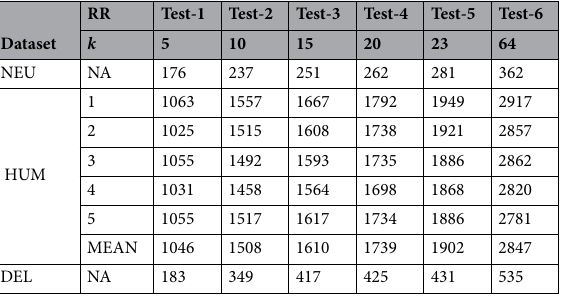
Table 1. The test sets and the number of genes used for the experiments are presented. (NA indicates not applicable).